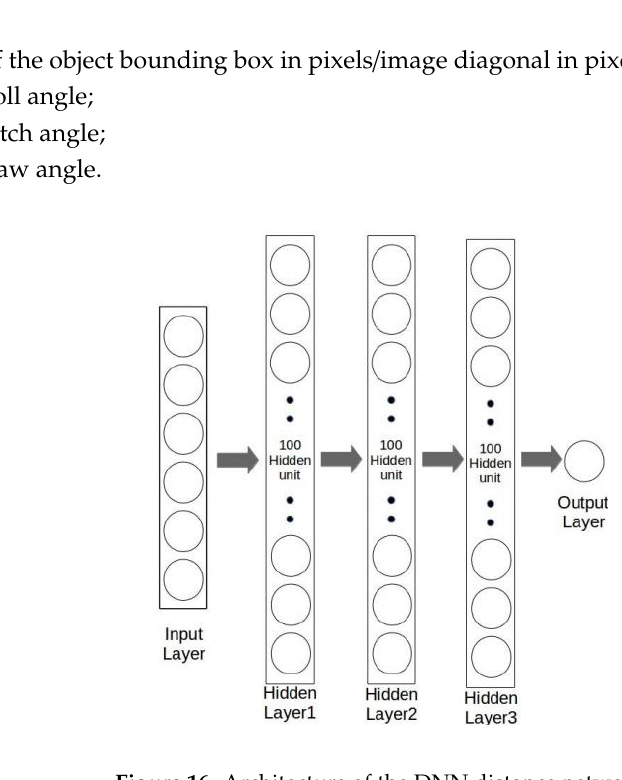
Figure 16. Architecture of the DNN distance network.